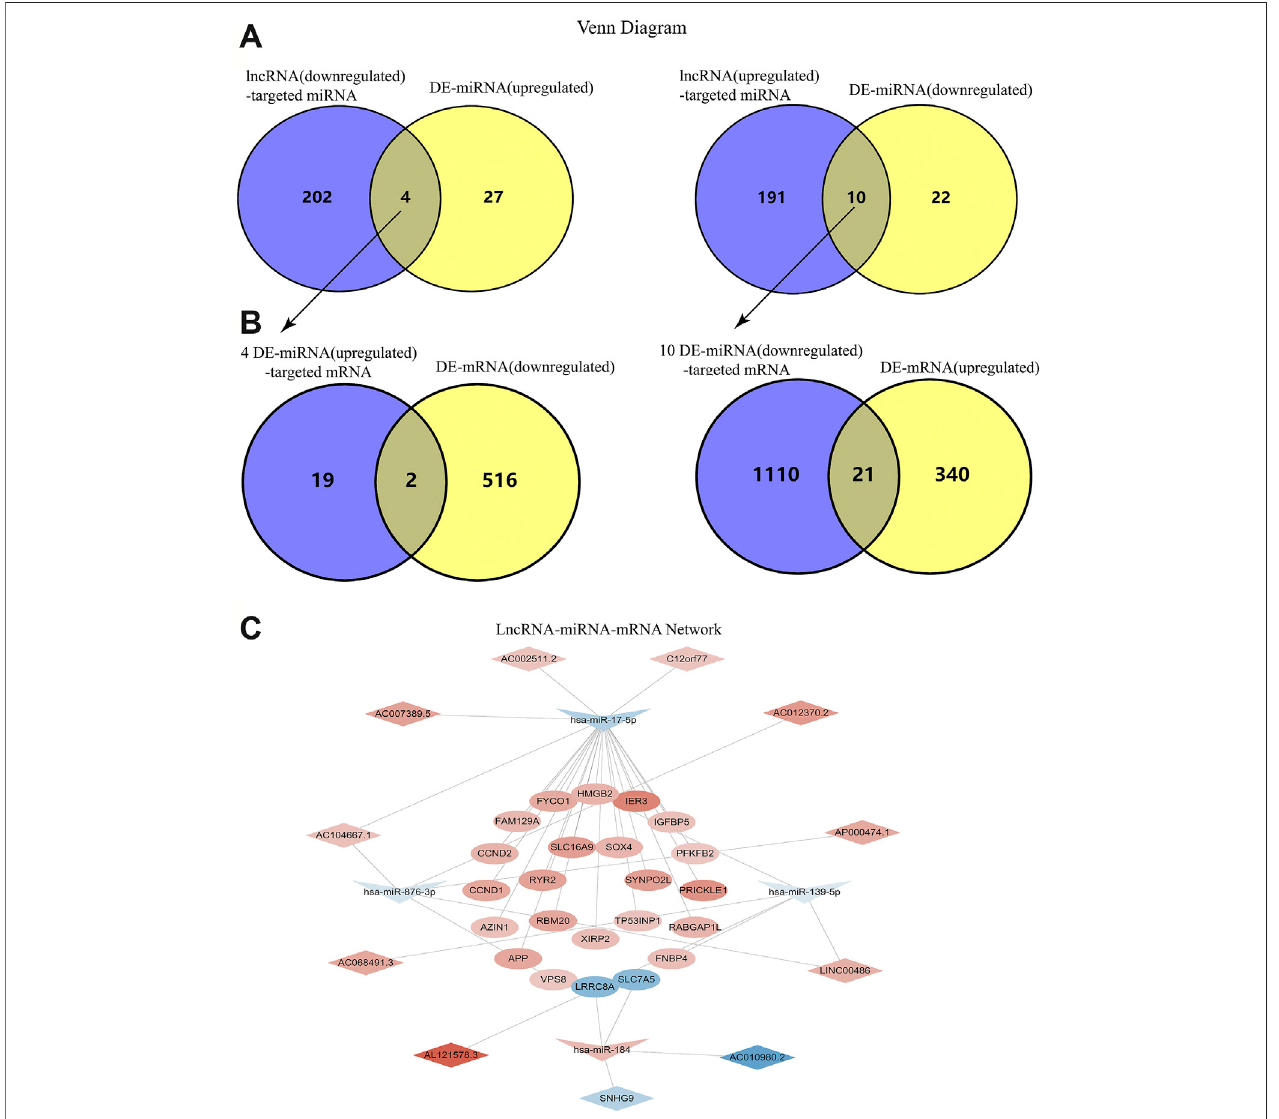
FIGURE 2 | Construction of the LncRNA-miRNA-mRNA Network. (A) Venn diagrams of the intersection between downregulated lncRNA-targeted miRNA and upregualted miRNA, as well as the intersection between upregulated lncRNA-targeted miRNA and downregualted miRNA. (B) Venn diagrams of the intersection between four upregulated miRNA-targeted mRNA and downregualted mRNA, as well as the intersection between ten downregulated miRNA-targeted mRNA and upregualted mRNA. (C) The interaction network among lncRNA, miRNA and mRNA.